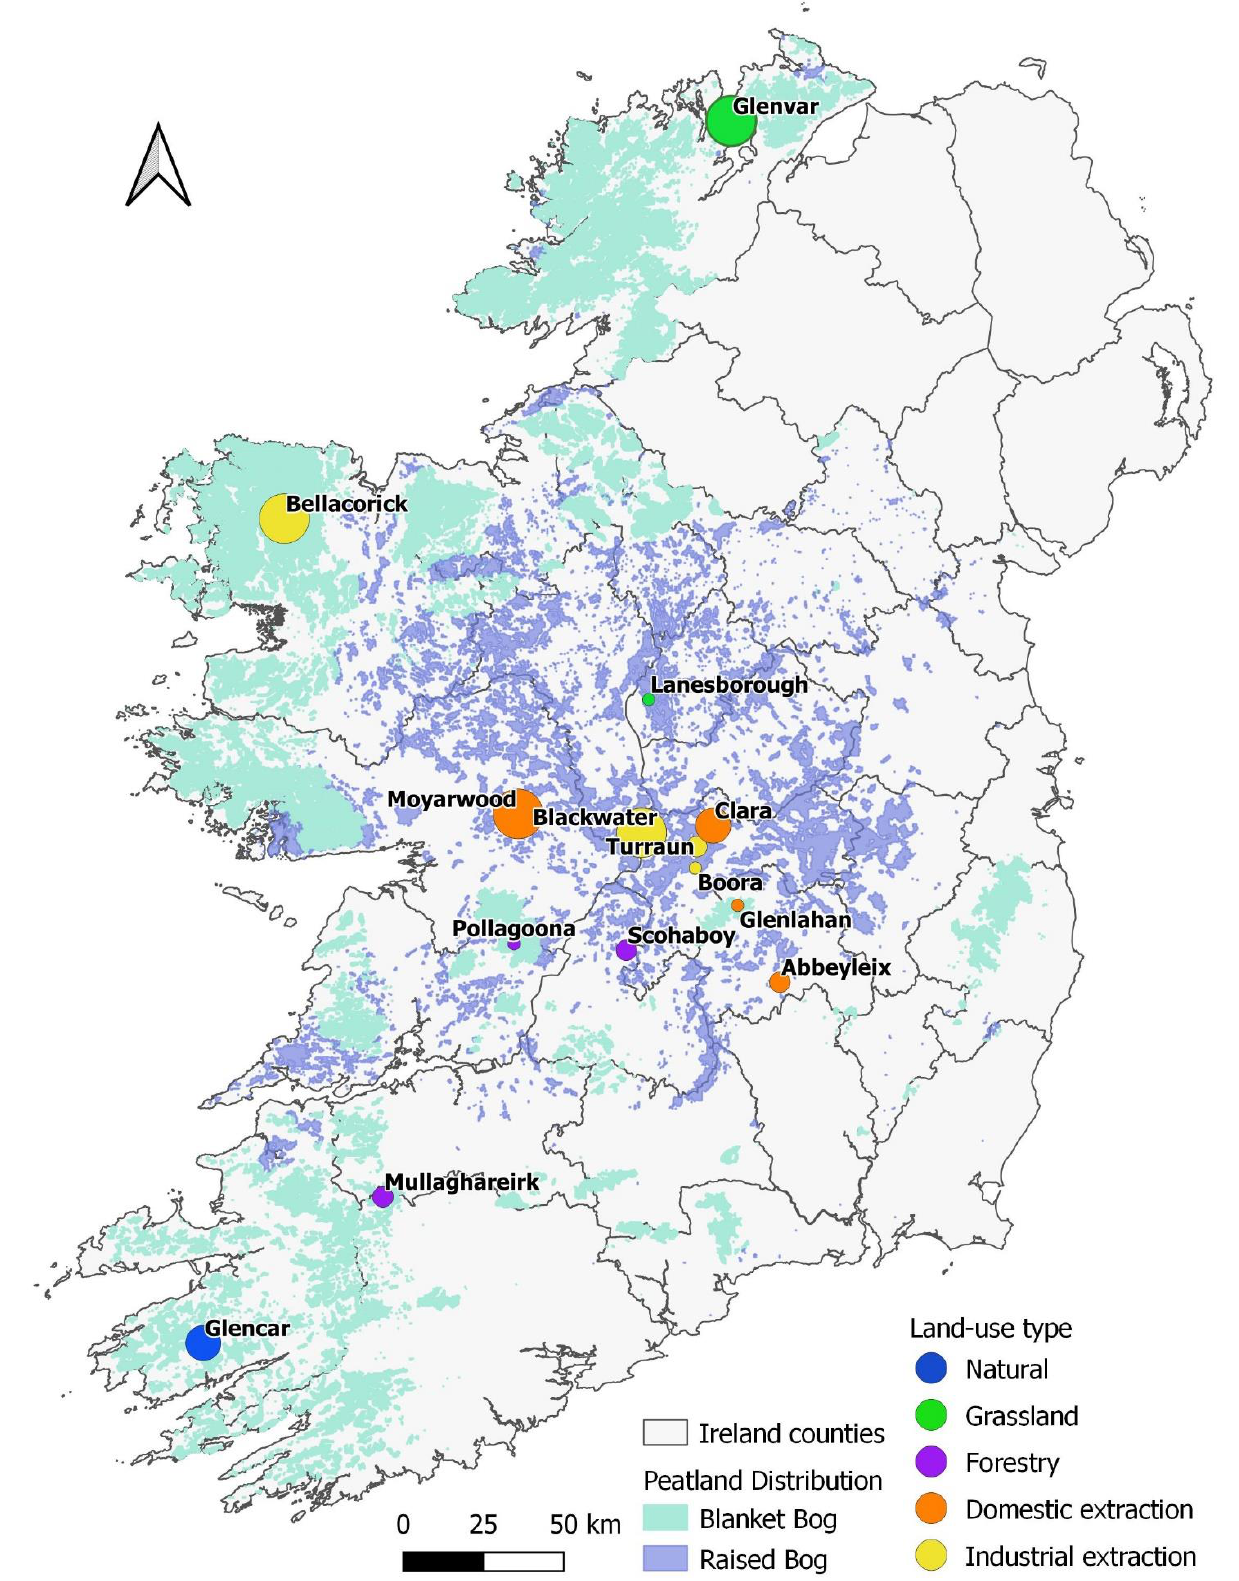
Figure 2. Map of Ireland showing the distribution of bogs (Connolly & Holden 2009) and locations of the study sites. Size of the icon represents the relative number of annual measurements (CO and fluvial fluxes combined) from this